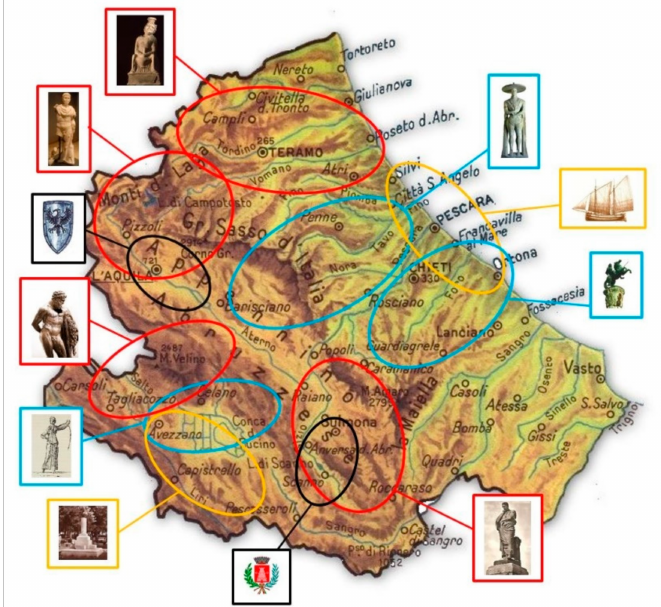
Figure 3. Subdivision by historical aspects.